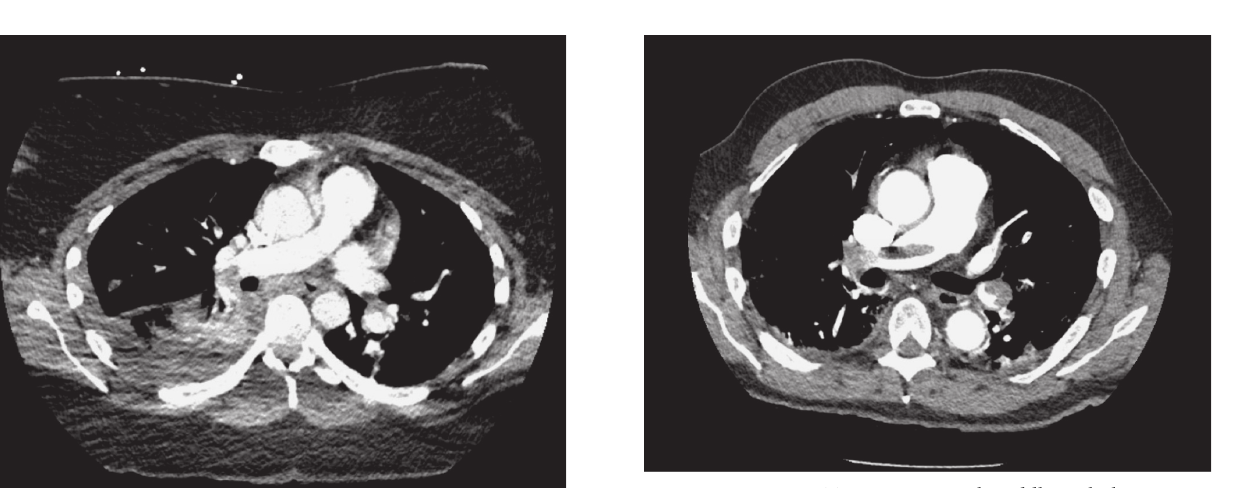
Figure 2: CT angiogram with saddle